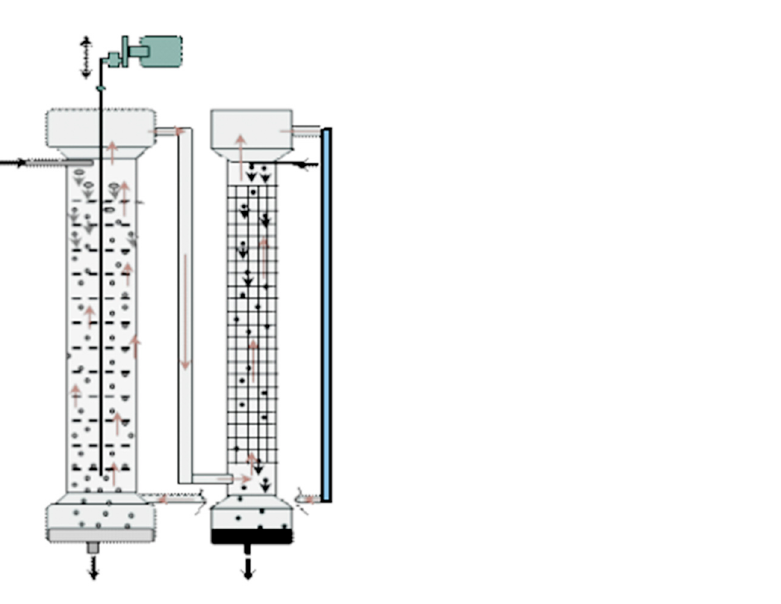
Figure 7. The process of multistage three-phase extraction separation in a cascade of two-column three-phase apparatuses with recirculation of the stripping phase at each stage.